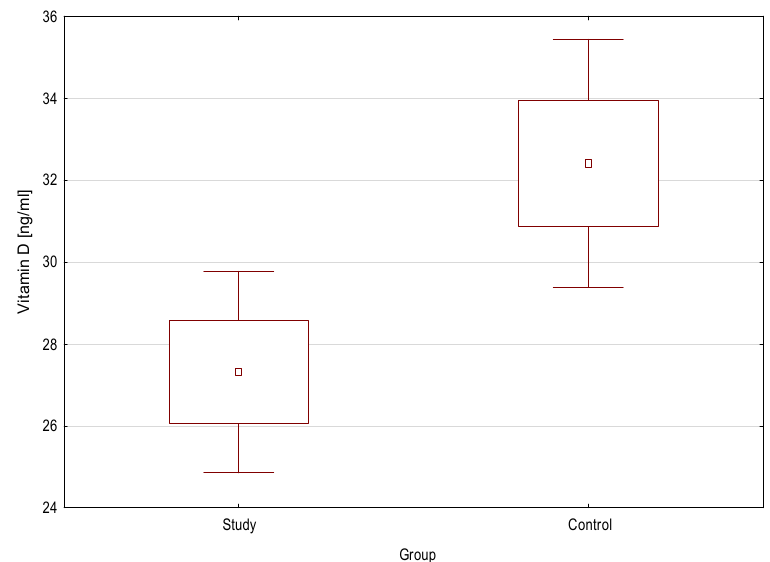
Figure 1. Vitamin D concentration in the study group and the control.